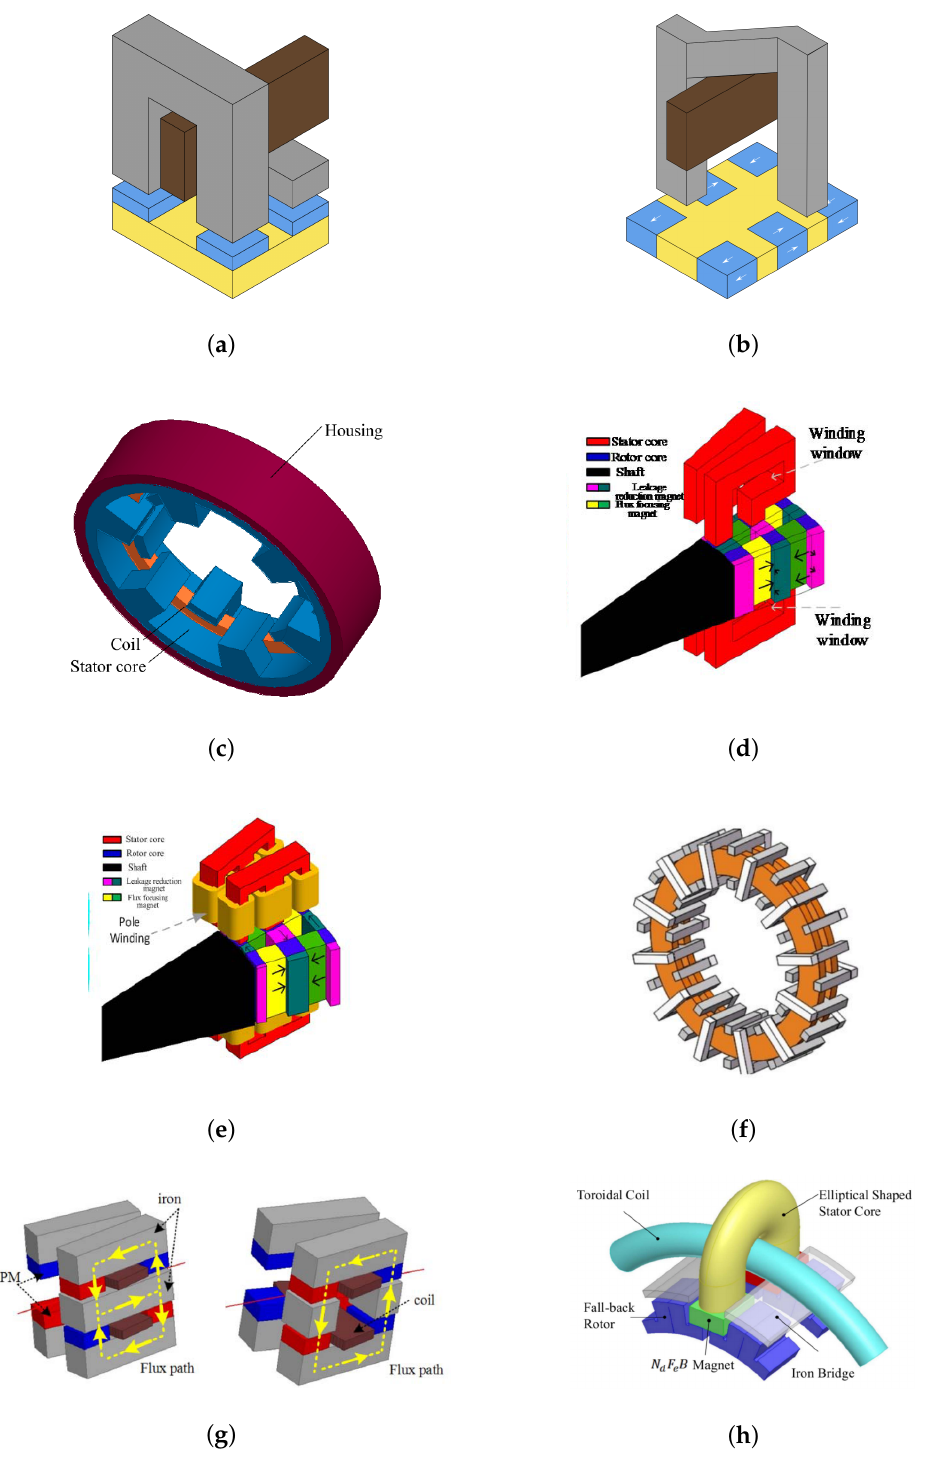
Figure 9. ( a ) U-core and I-bridges, ( b ) C-core, ( c ) claw-pole [16], ( d ) quasi-U [59], ( e ) E-core [59], ( f ) H-core [66], ( g ) I-core [76], and ( h ) elliptical-shaped